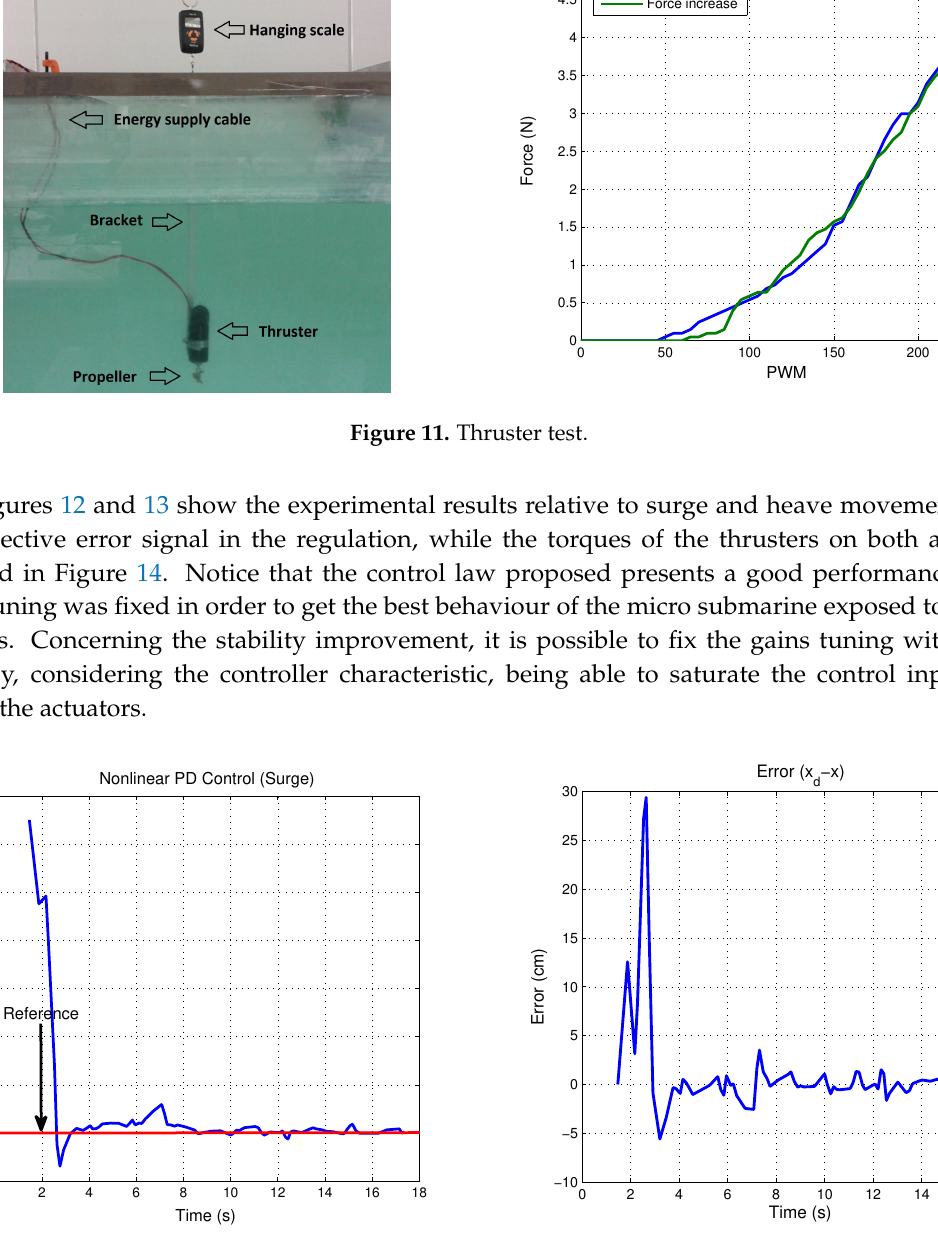
Figure 12. Experimental surge movement and its signal of error in